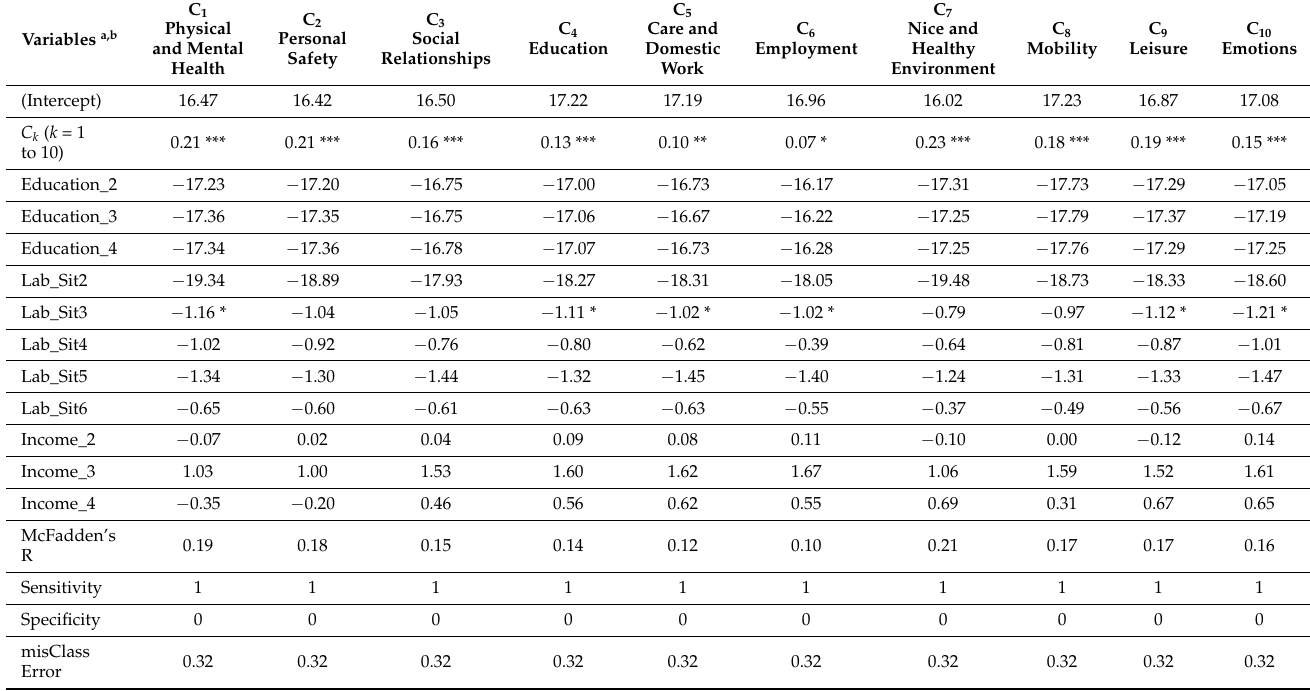
Table A6. Significance of coefficients of regressions with different capabilities. Men and age 18 to 39.